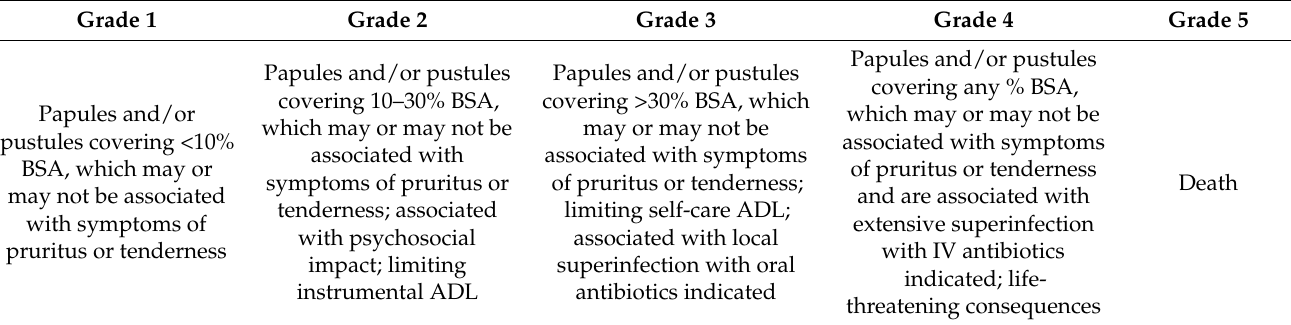
Table A1. Classification of the severity of rash acneiform (CTCAE